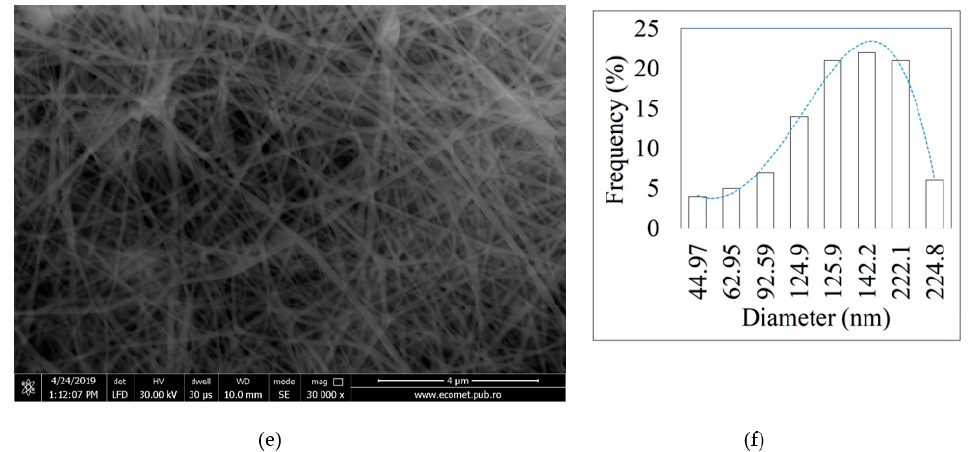
Figure 1. Scanning electron microscopy (SEM) images and fibers size for electrospun protein-based nanofibers: ( a , b ) HC10CC, ( c , d ) RCG, and ( e , f ) KH.